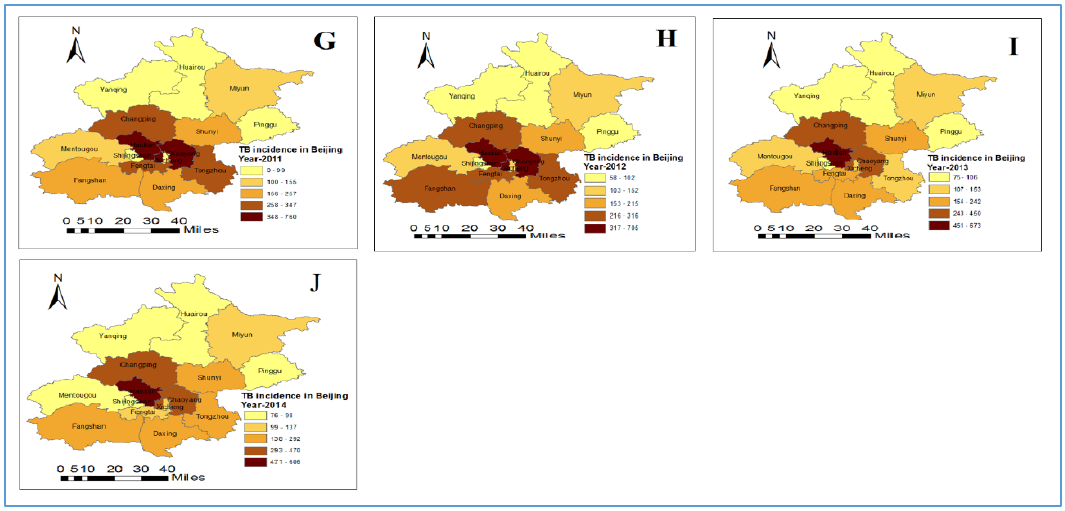
Figure 1. Trends of pulmonary tuberculosis (TB) incidence in Beijing districts, from 2005–2014 as respective ( A – J ) in the figure.